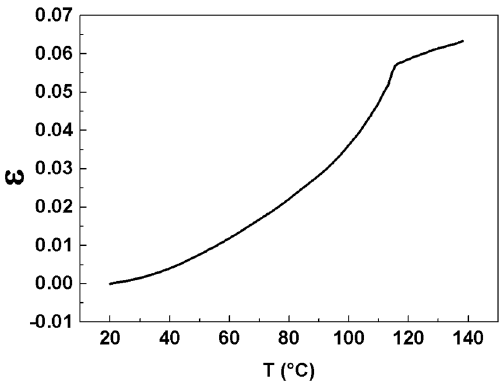
Figure 6. Linear strain ε vs temperature, T, of an LDPE